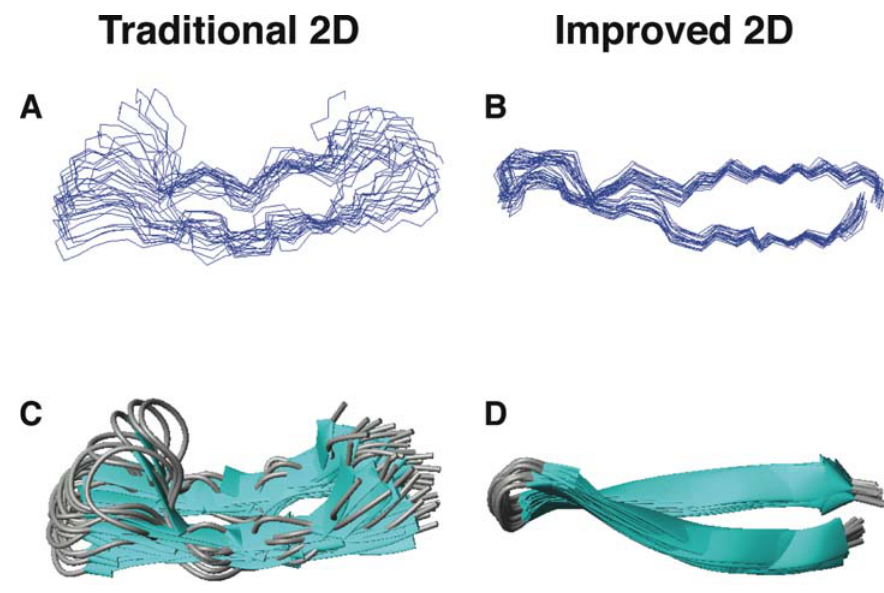
Figure 6. Three-dimensional structures of RTD-1 determined by traditional (panels A and C) and improved 2D NMR methods (panels B and D) [117,118]. Shown are ensembles of backbone structures (A and B) and ribbon diagrams (C and D). Data were obtained from the Protein Data Bank (PDB entries: 1HVZ and 2LYF)